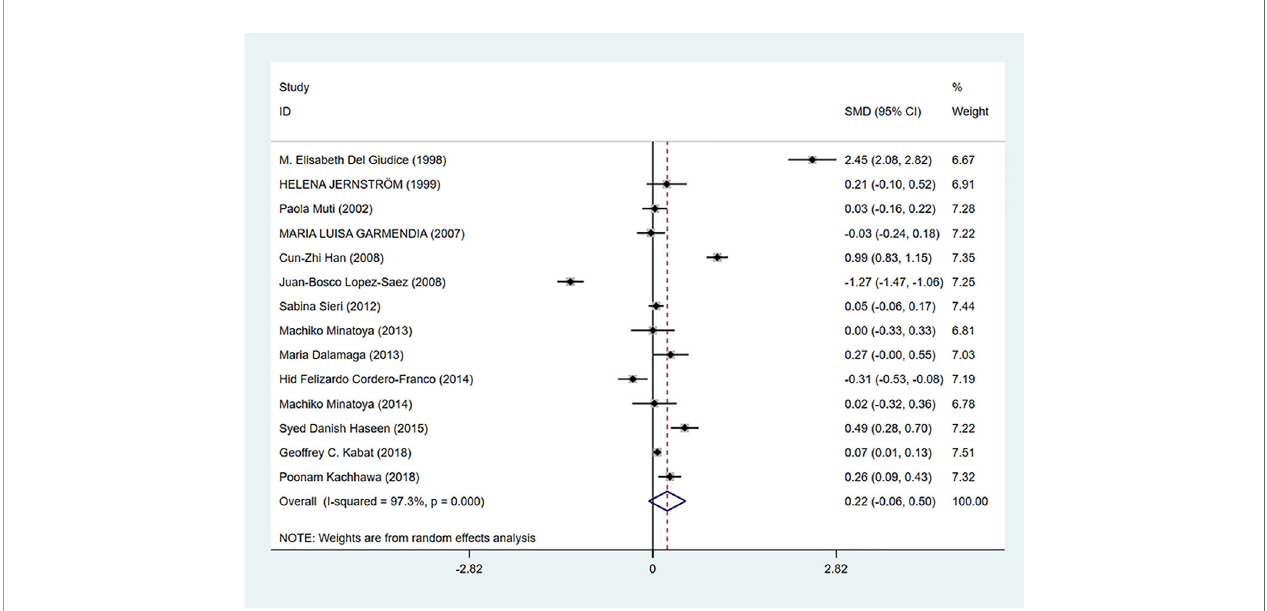
FIGURE 6 | Overall forest plot of meta-analysis on the association between insulin and breast cancer risk. The size of the square box is proportional to the weight that each study contributes in the meta-analysis. The overall estimate and CI are marked by a diamond. Summary estimates were analyzed using a random-effects model. Zero is included in this con fi dence interval, which indicates that insulin levels had no association with breast cancer risk.